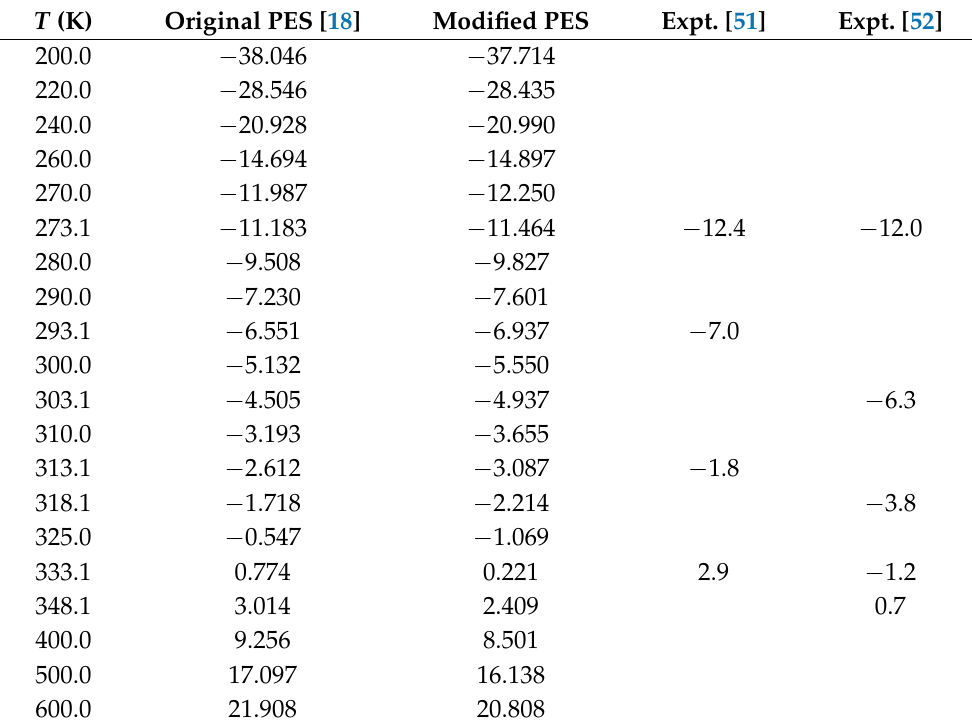
Table 3. Calculated and experimental second virial coefficient B ( T ) in cm 3 /mol as a function of